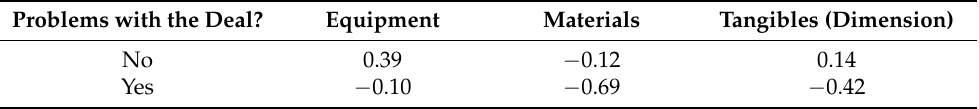
Table 3. Average service quality scores on equipment, materials, and the dimension tangibles for groups with and without problems during the timber deal. Differences between groups were significant on all three items ( p < 0.01).